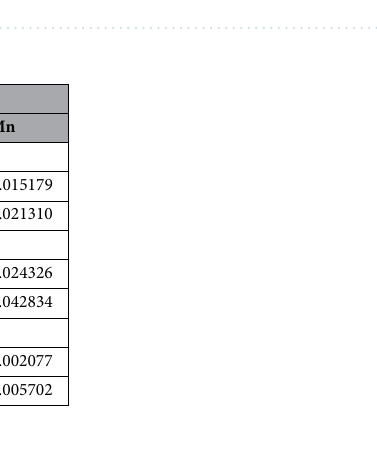
Table 6. Bioaccumulation factor (BAF). NC not calculated.